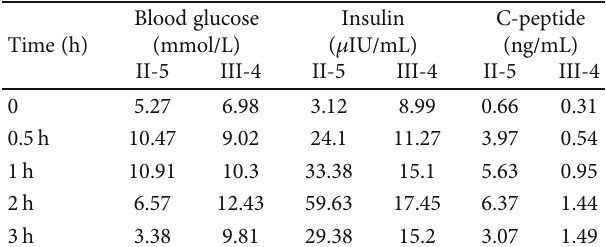
Table 1: Blood glucose, insulin, and C-peptide levels of the proband and her mother. Time